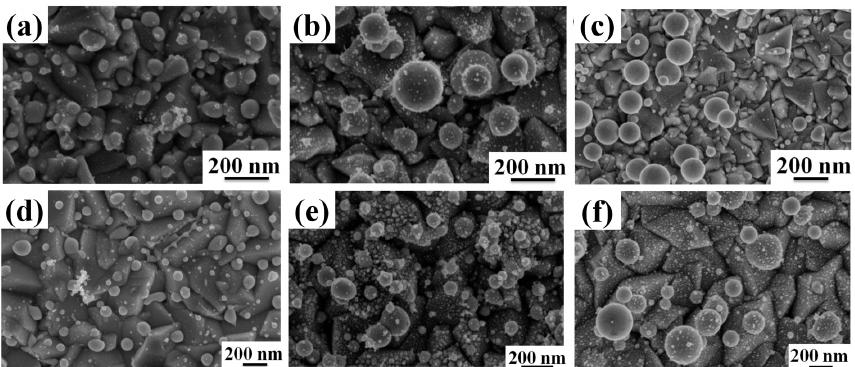
Figure 9. Enlarged SEM images, acquired near the laser spot center (i.e., region 3), of the nanoparticles formed by irradiating the AuPd film with thickness 9.8 nm ( a , d ), 19.8 nm ( b , e ), and 48.6 nm ( c , f ) deposited on the untreated FTO ( a – c ) and on the textured FTO ( d – f ).